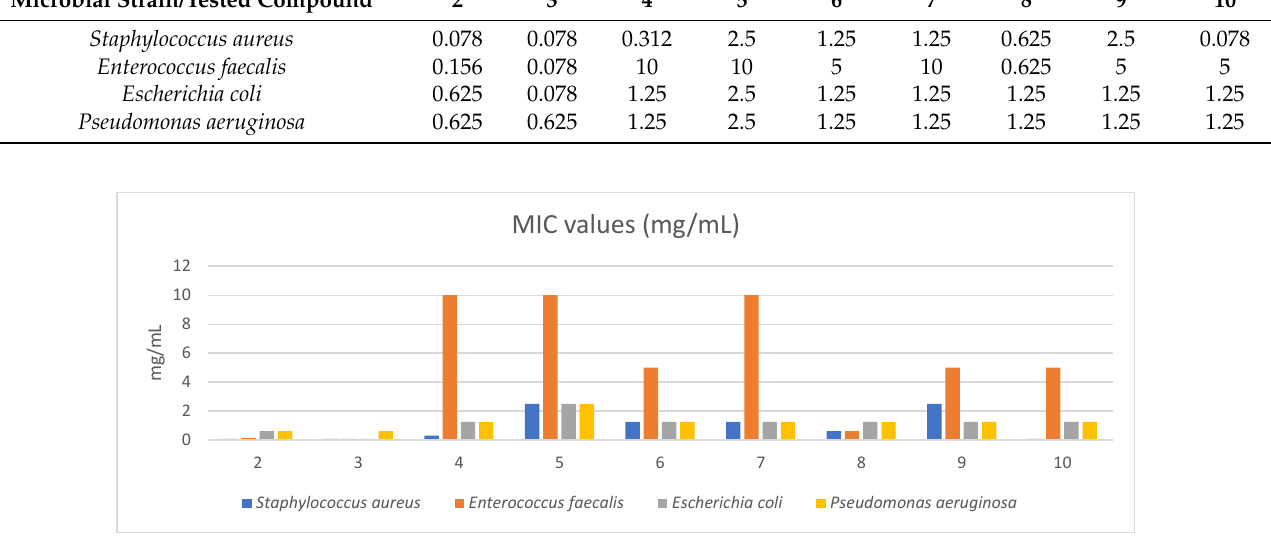
Figure 7. MIC concentrations of the tested compounds against the tested strains.